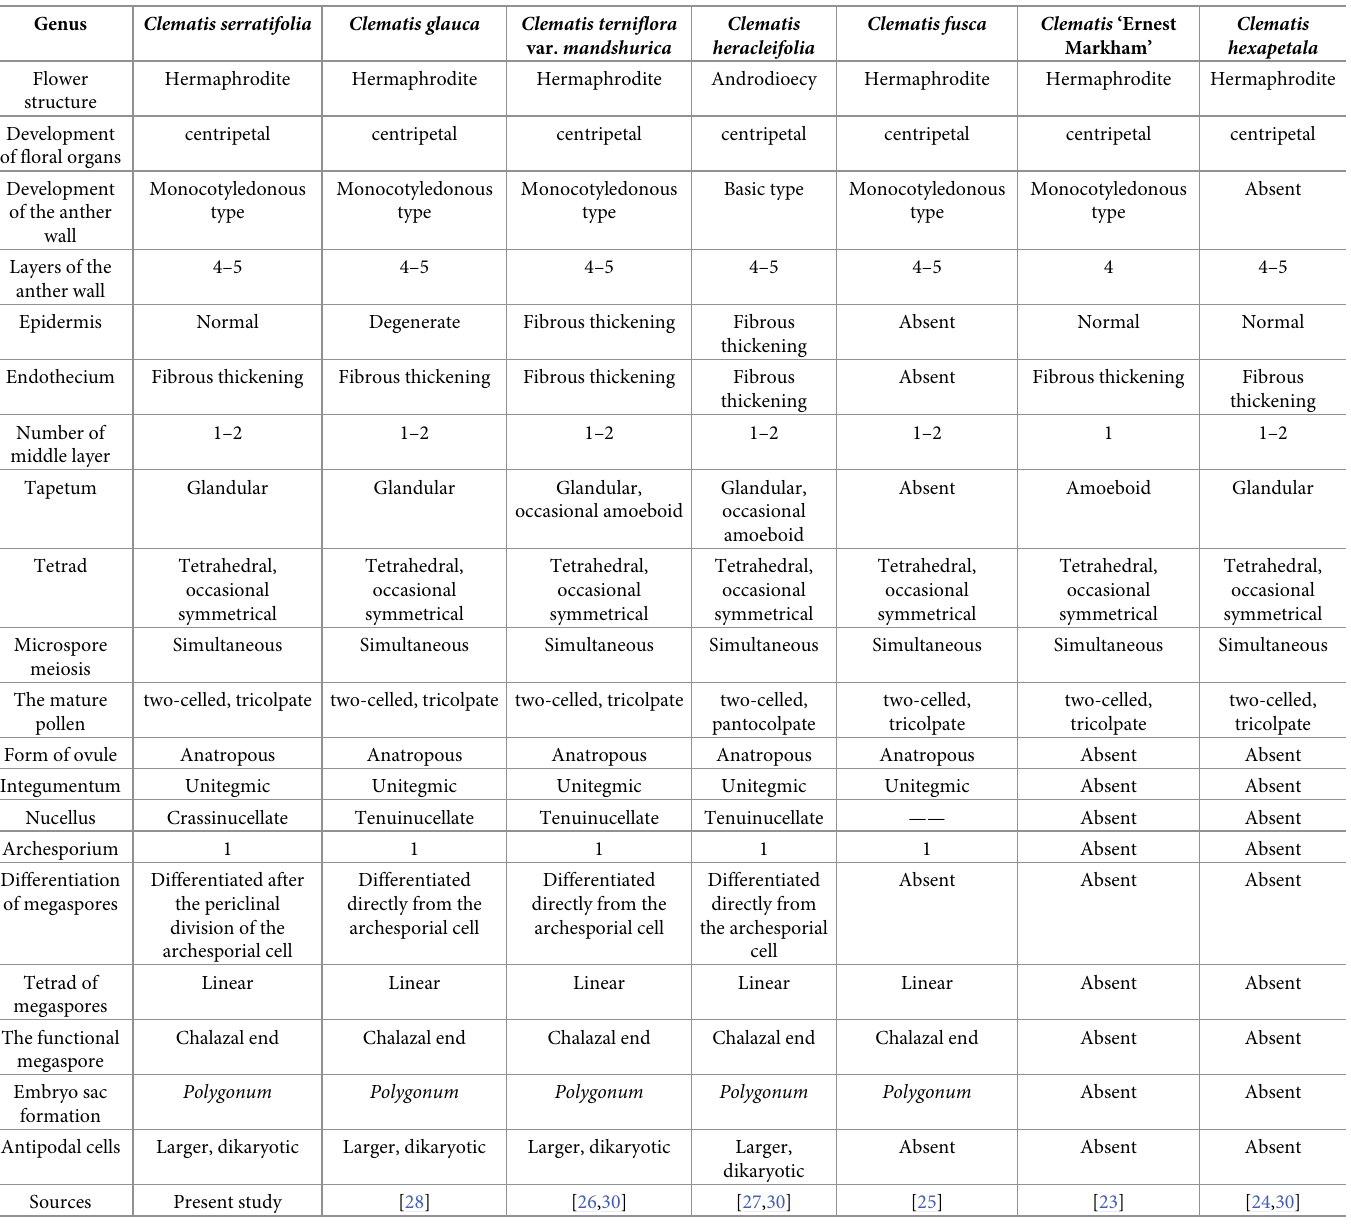
Table 3. Early embryological characteristics of seven species in Clematis